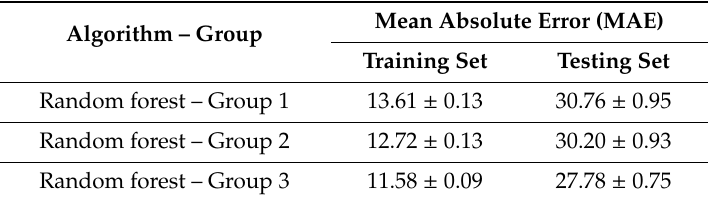
Table 9. Mean absolute error (mean ± standard deviation) of annual EUI for training and testing sets of three groups of predictors (Figure 3) used in the Random Forest model.